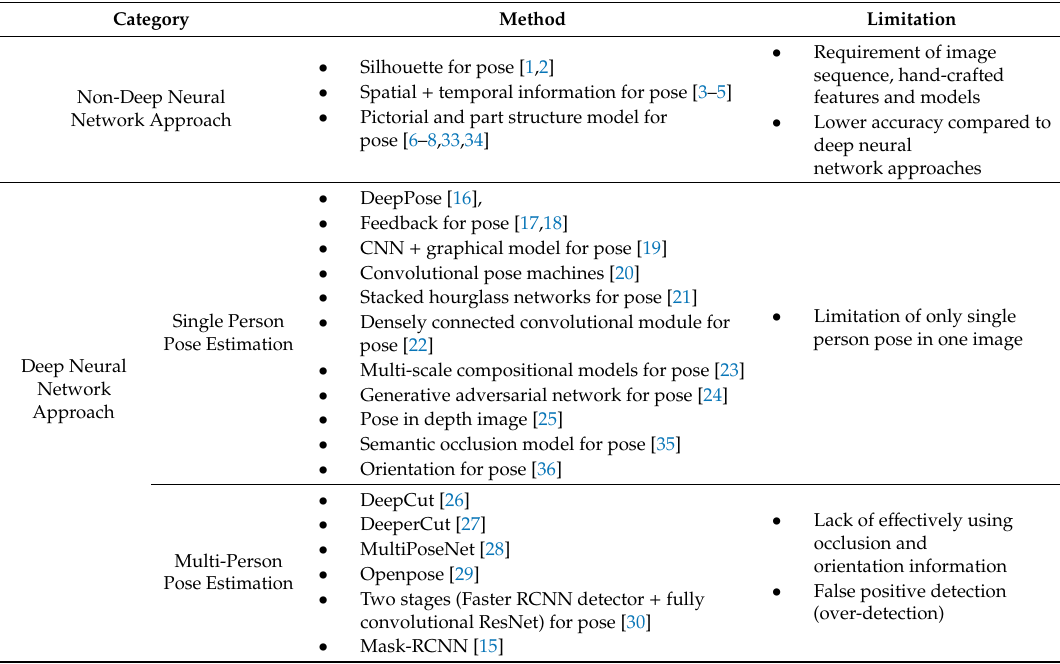
Table 1. A comparative overview between the di ff erent previous